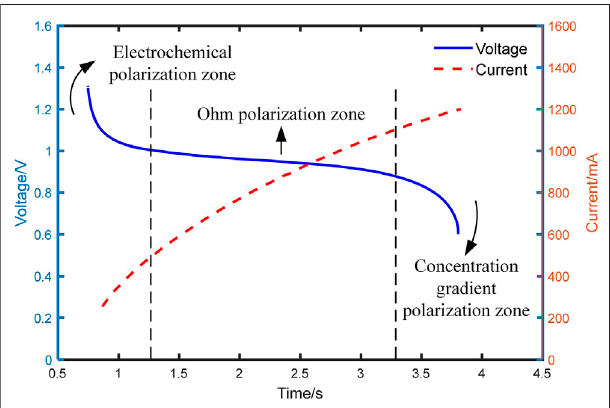
FIGURE 3 | Polarization curve of PEMFC power